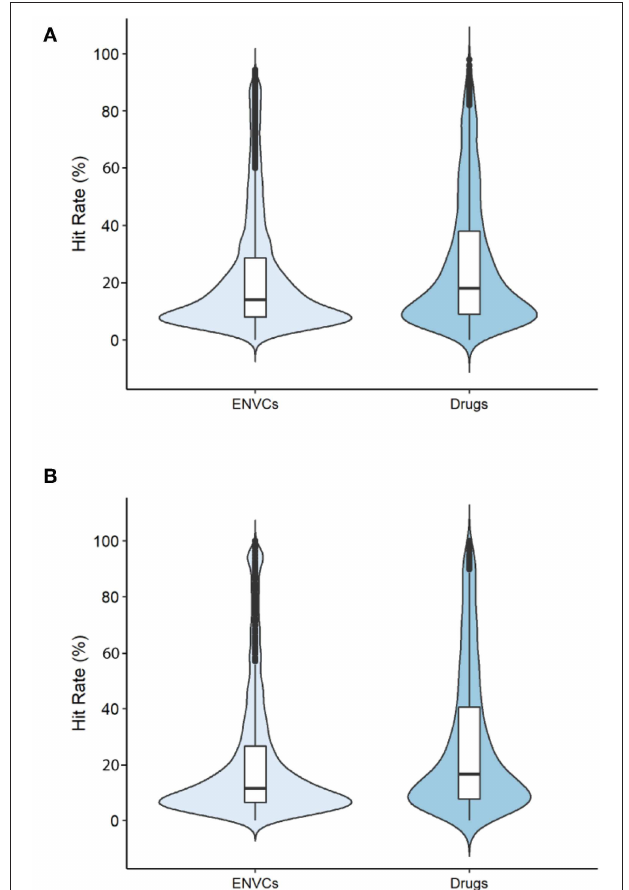
FIGURE 2 | Hit rates of drugs and ENVCs when screened against (A) all assays or (B) only viability